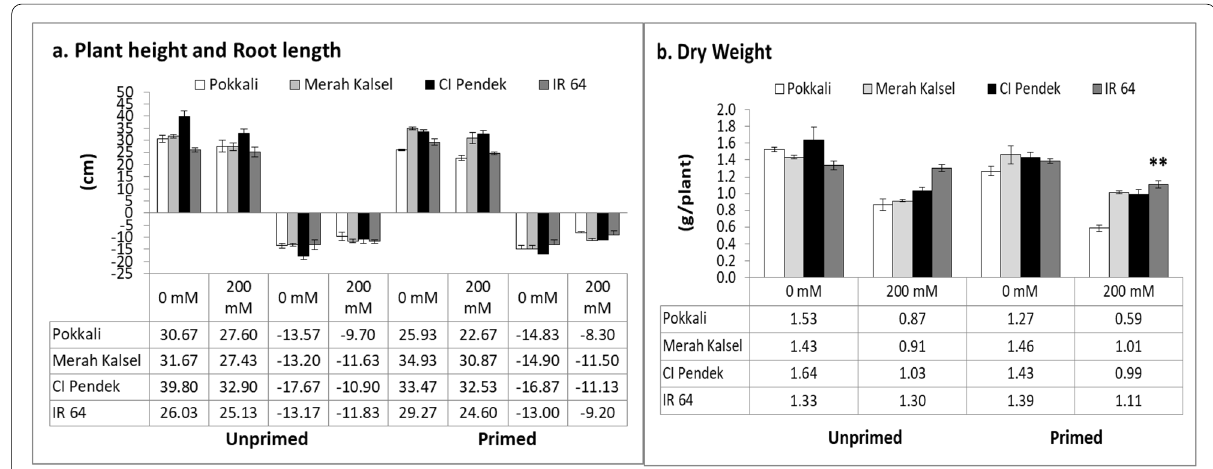
Fig. 3 Effect of salinity stress on agronomic parameters of rice plants. a Plant height and root length and b dry weight of whole plant with and without priming were measured 7 days after salinity stress. Values are means of three replicates